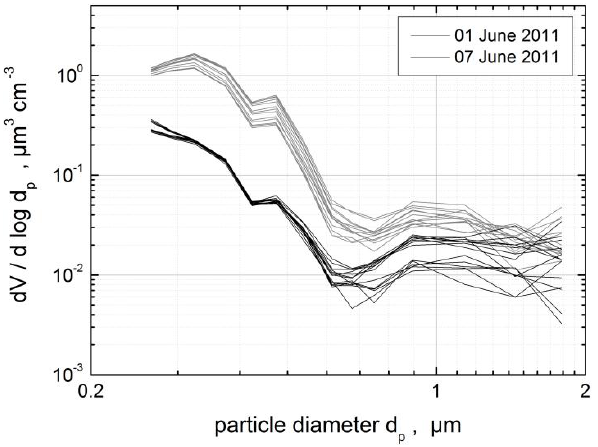
Fig. 10. Volume size distributions for 1 June (high pollution se- quence; ordinal day 152) and 7 June (moderate pollution sequence; Figure 10. Volume size distributions for 01 June (high pollution sequence; ordinal day 152) ordinal day 158) calculated from OPC size and 07 June (moderate pollution sequence; ordinal day 158) calculated from OPC size distributions.